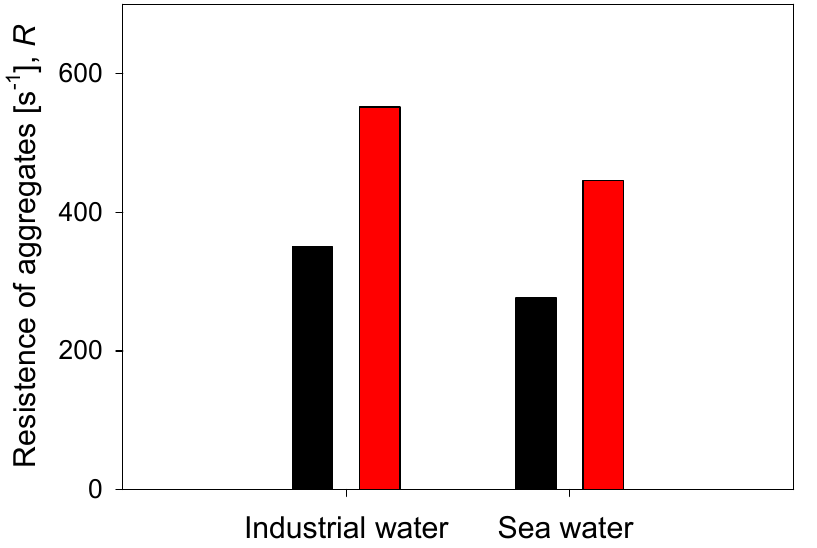
Figure 10. Effect of water type on the resistance of kaolin aggregates ( R ) flocculated at two doses of flocculant after 60 s flocculation time.